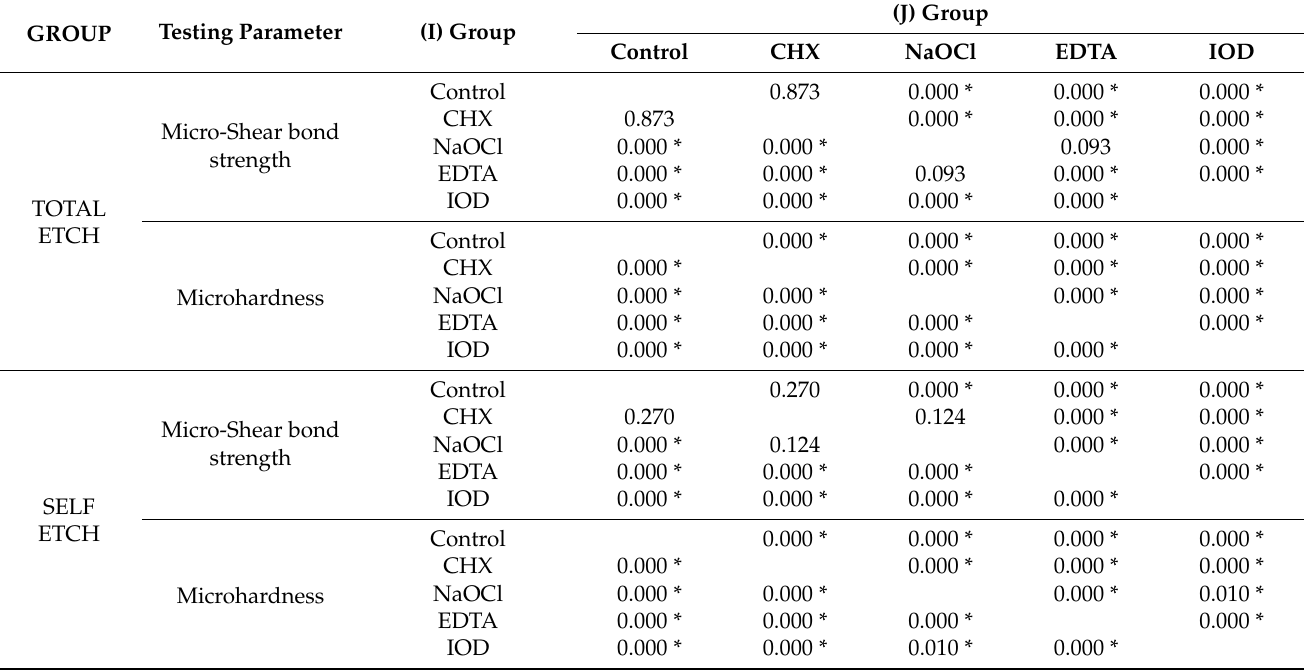
Table 4. Tukey HSD post hoc multiple comparison tests of different surface disinfection group for mean micro-shear bond strength and